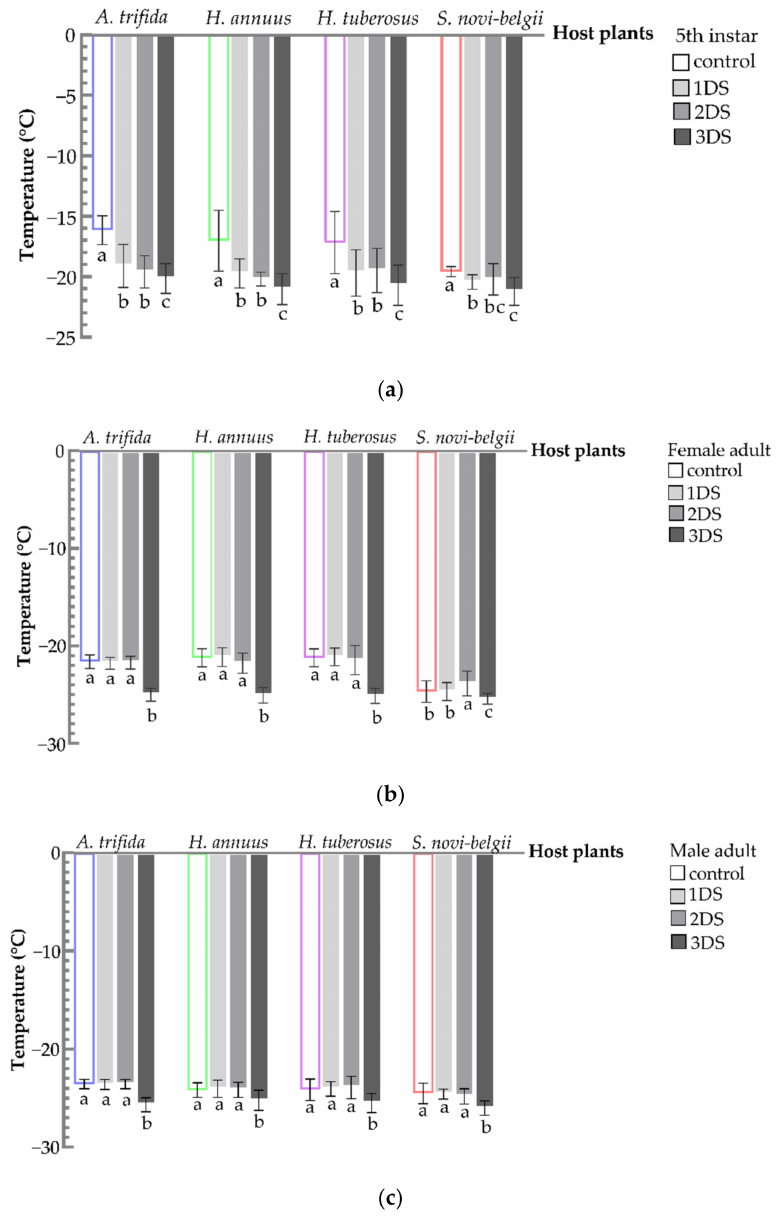
Figure 6. Supercooling point of C. marmorata suffering from food deprivation on four host plants. ( a ) SCP of 5th instar nymph; ( b ) SCP of female adult; and ( c ) SCP of male adult. Control: the